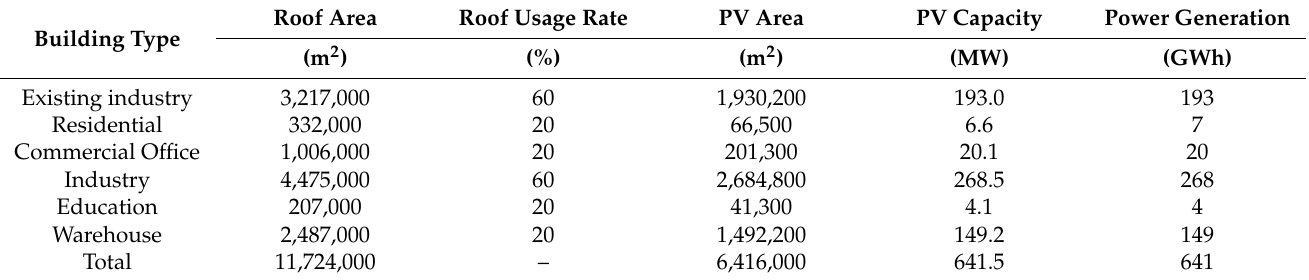
Table 11. PV layout plans for different types of buildings by 2050 (40 MW in existence).